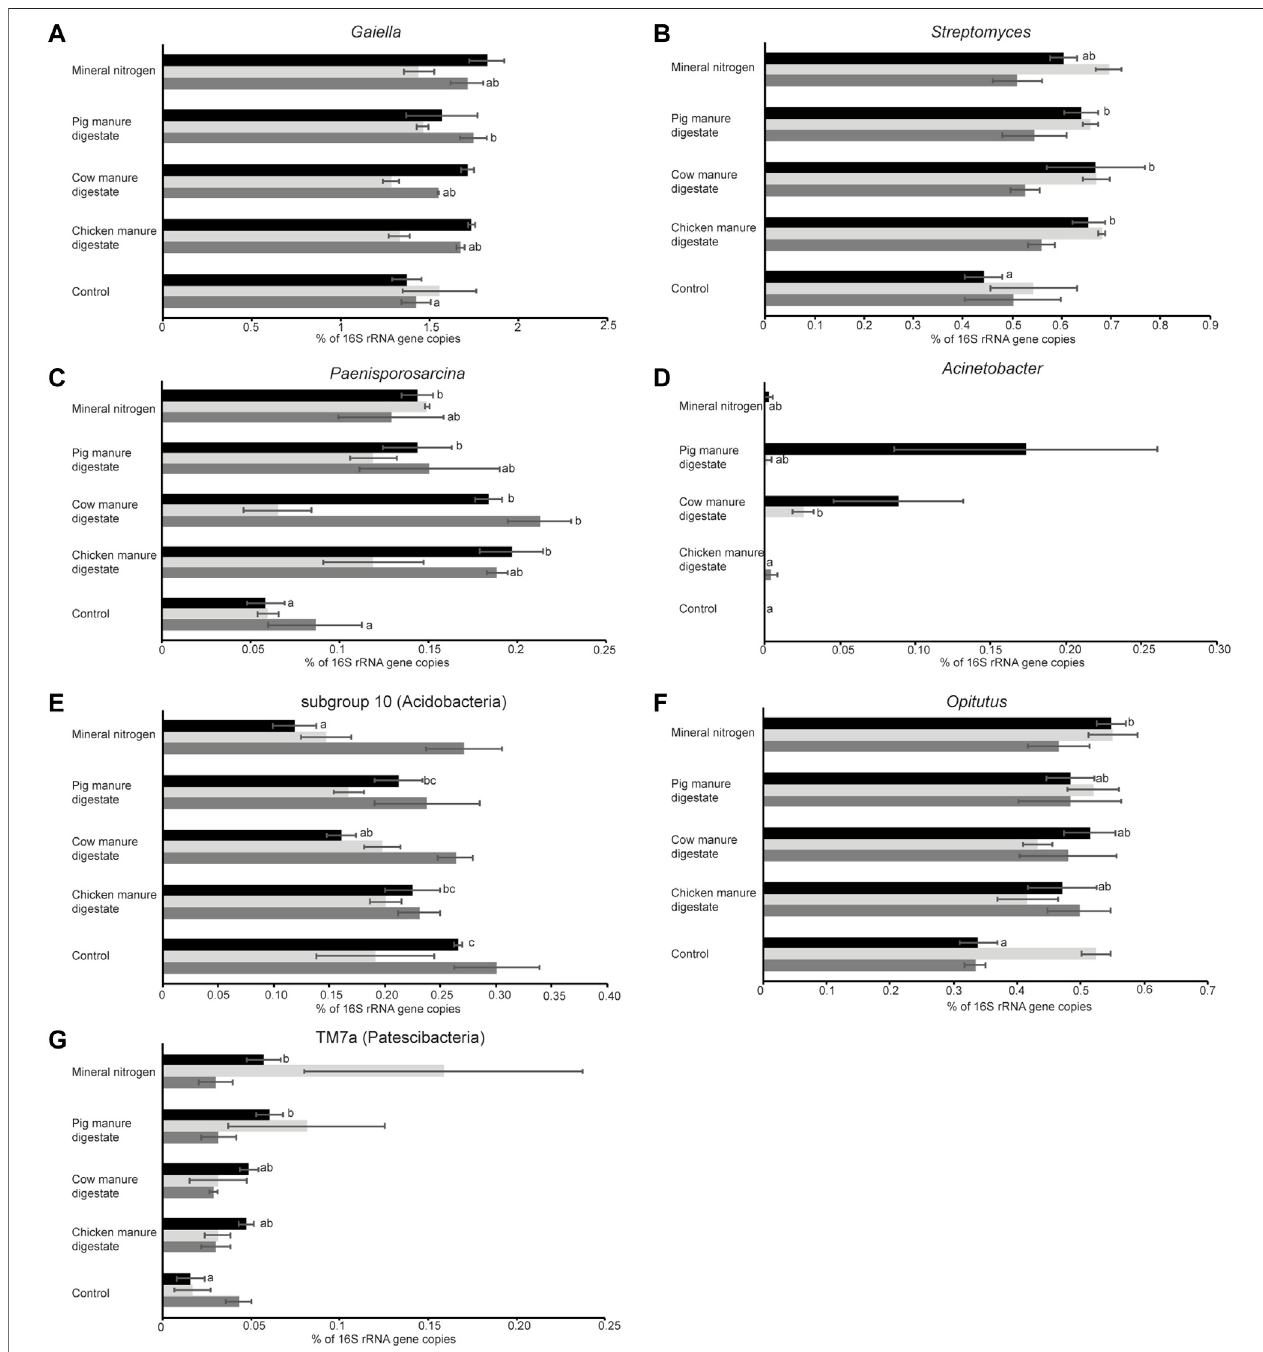
FIGURE6| Effectofthedifferentfertilizersusedatthegenuslevelafterharvest.Eachbarislabeledrespectivetothetreatmentappliedandcoloredrespectivetothe year of treatment: black (2018, fi rst year), light gray (2019, second year), and dark gray (2020, third year). (A) Gaiella , (B) Streptomyces , (C) Paenisporosarcina , (D) Acinetobacter , (E) Acidobacteria subgroup 10, (F) Opitutus , and (G) TM7a (Patescibacteria). Means sharing the same letter within the same year are not signi fi cantly different (post hoc Tukey ’ s HSD test or Dunn ’ s test).